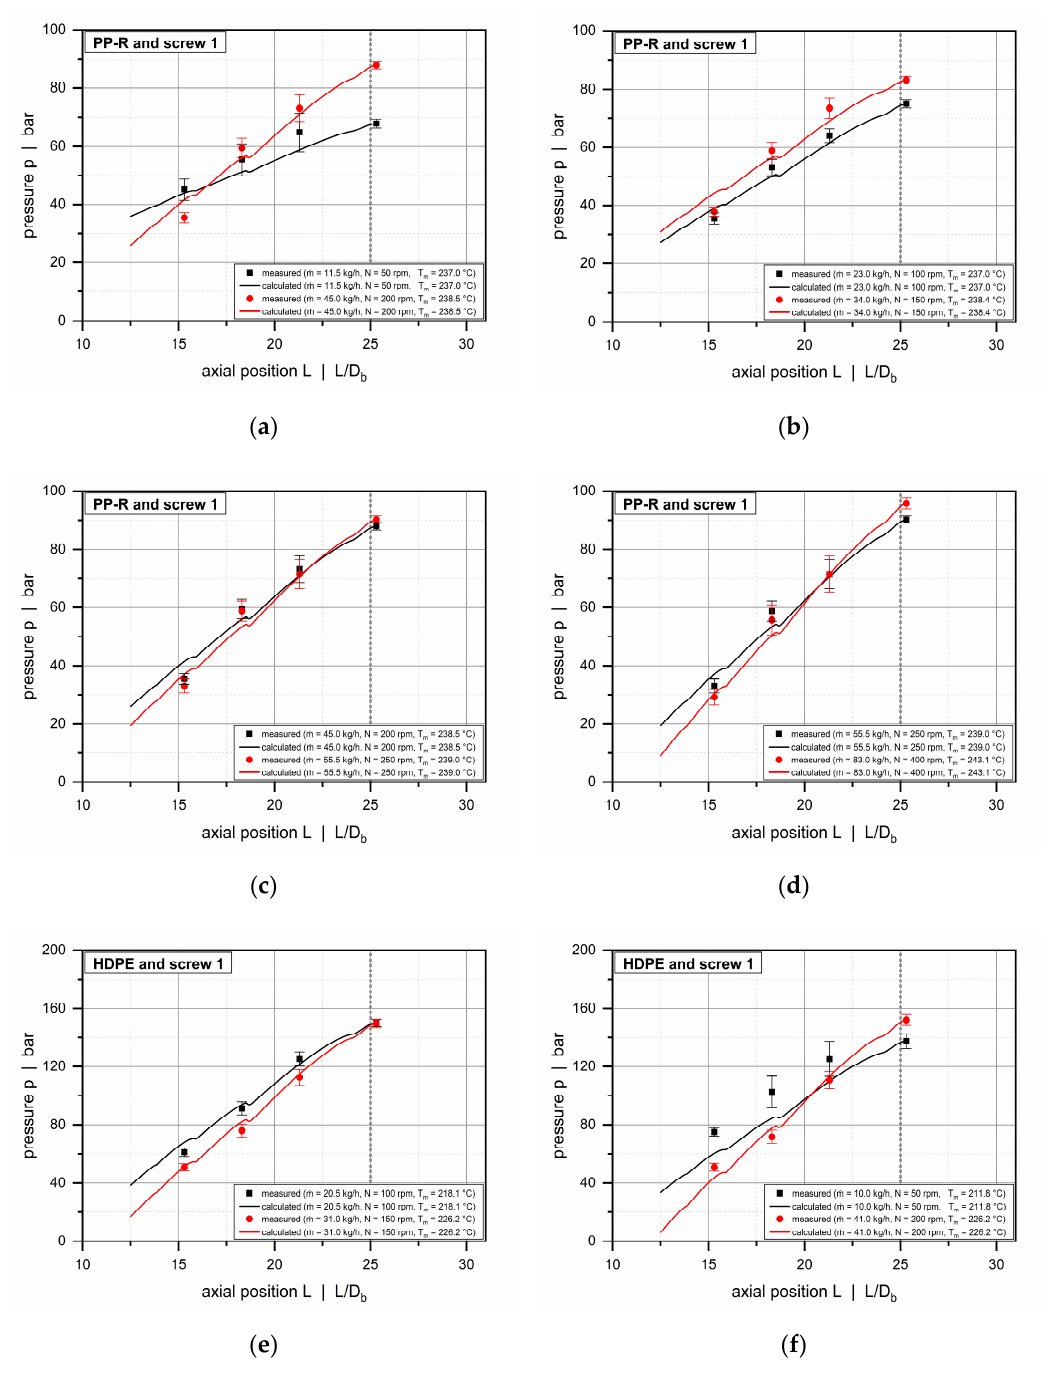
Figure 12. Comparison between experimental data and calculated solutions for barrel 1 and screw 1. Axial pressure profiles along the wave zone for PP-R ( a – d ) and HDPE ( e , f ). The continuous lines indicate the solutions of our semi-numerical modeling approach, while the circles illustrate experimental data.